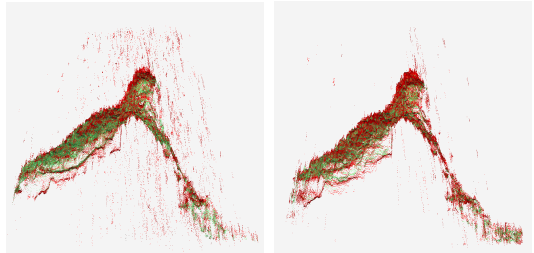
Figure 6. Side view of the statue analysis: binocular (left) and trinocular (right) with (green) and without (red)